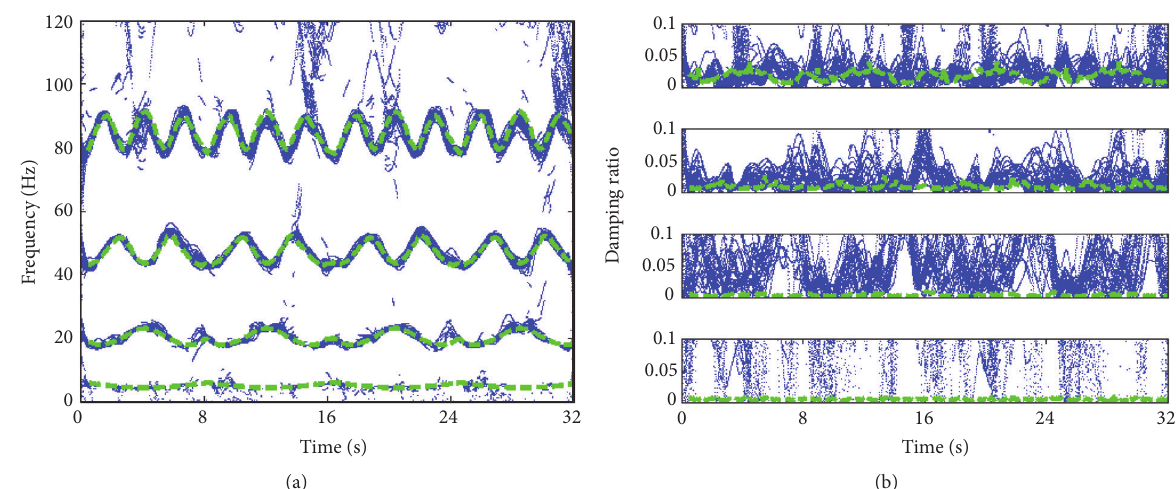
Figure16:KRR-FS-TARMAbasedmodalparameterMonteCarloestimates(30realizations):(a)naturalfrequencyestimatesand(b)damping ratio estimates.